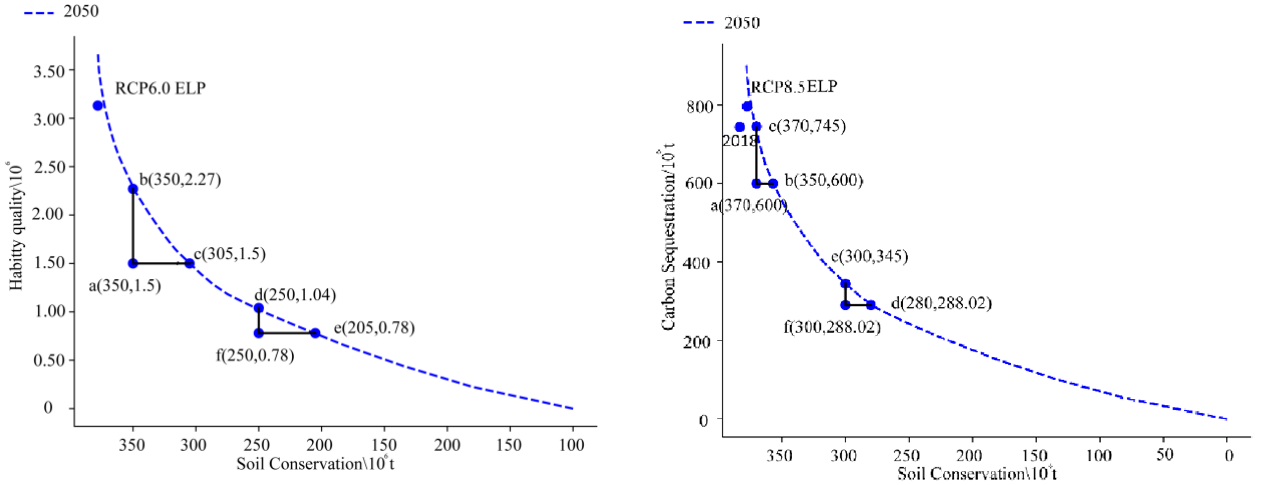
Figure 9. PPF curves between soil conservation and habitat quality and carbon sequestration.